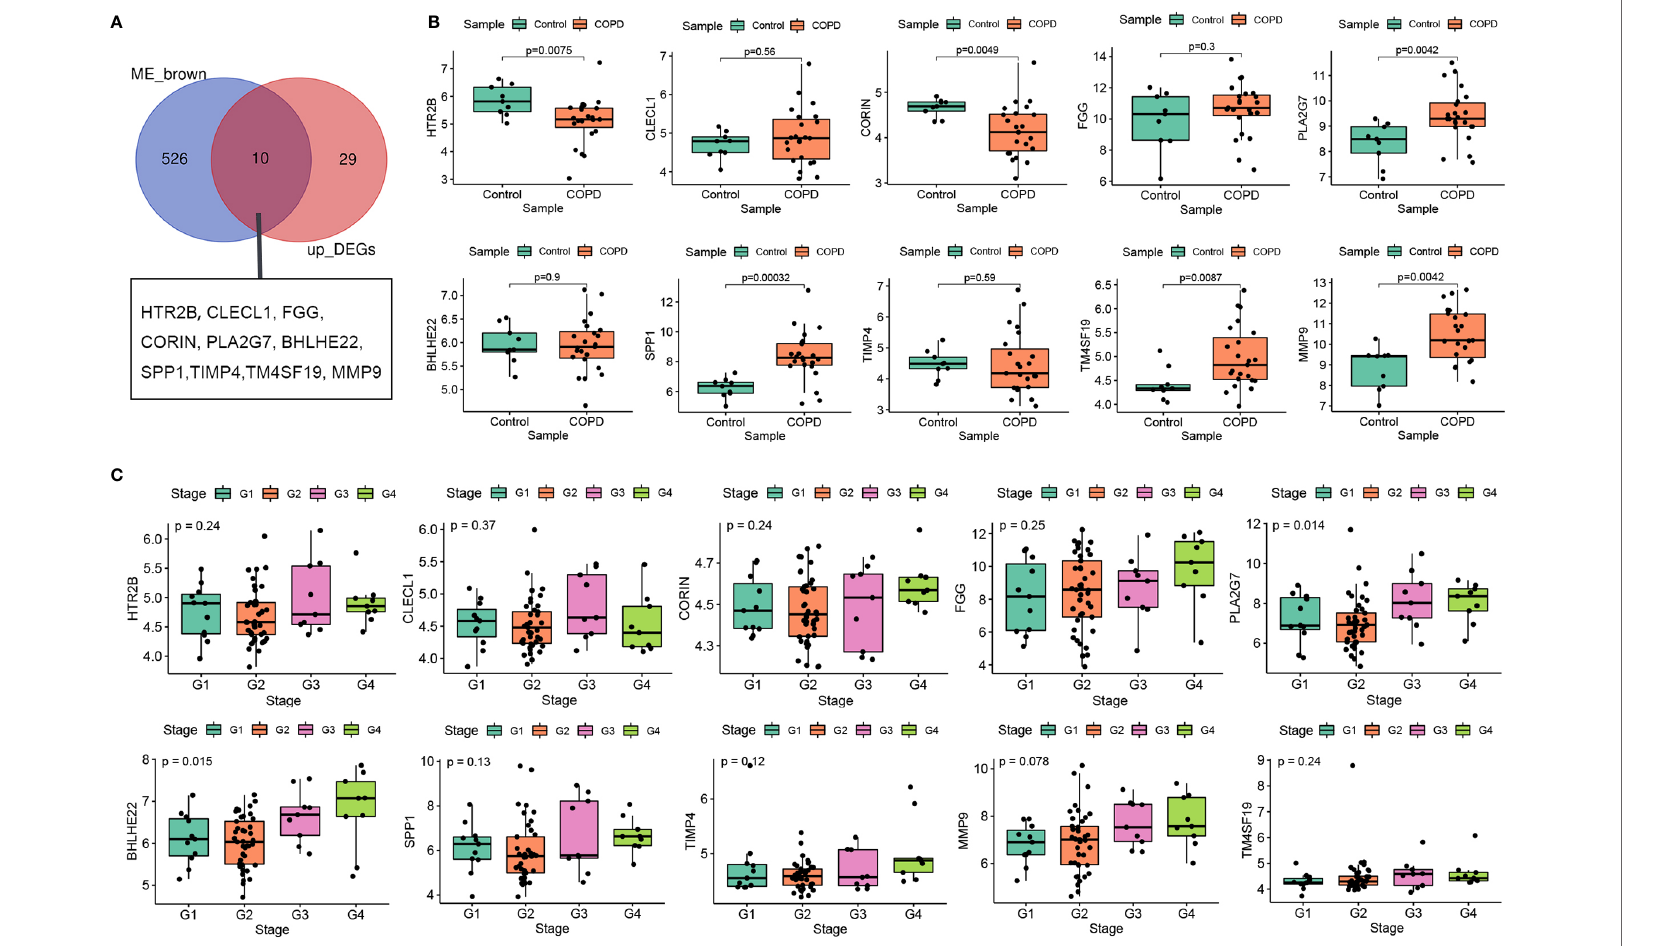
FIGURE 4 | Selection and validation of hub gene. (A) Venn diagrams to indicate 10 shared genes from brown module and DEGs; (B) Validation of hub genes in the dataset GSE38974; (C) Validation of hub genes in the dataset